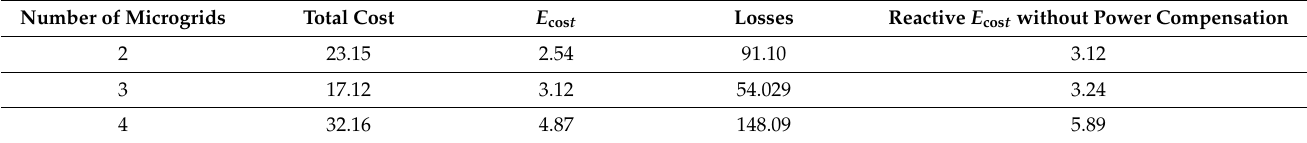
Table 9. Comparison of design with the creation of different